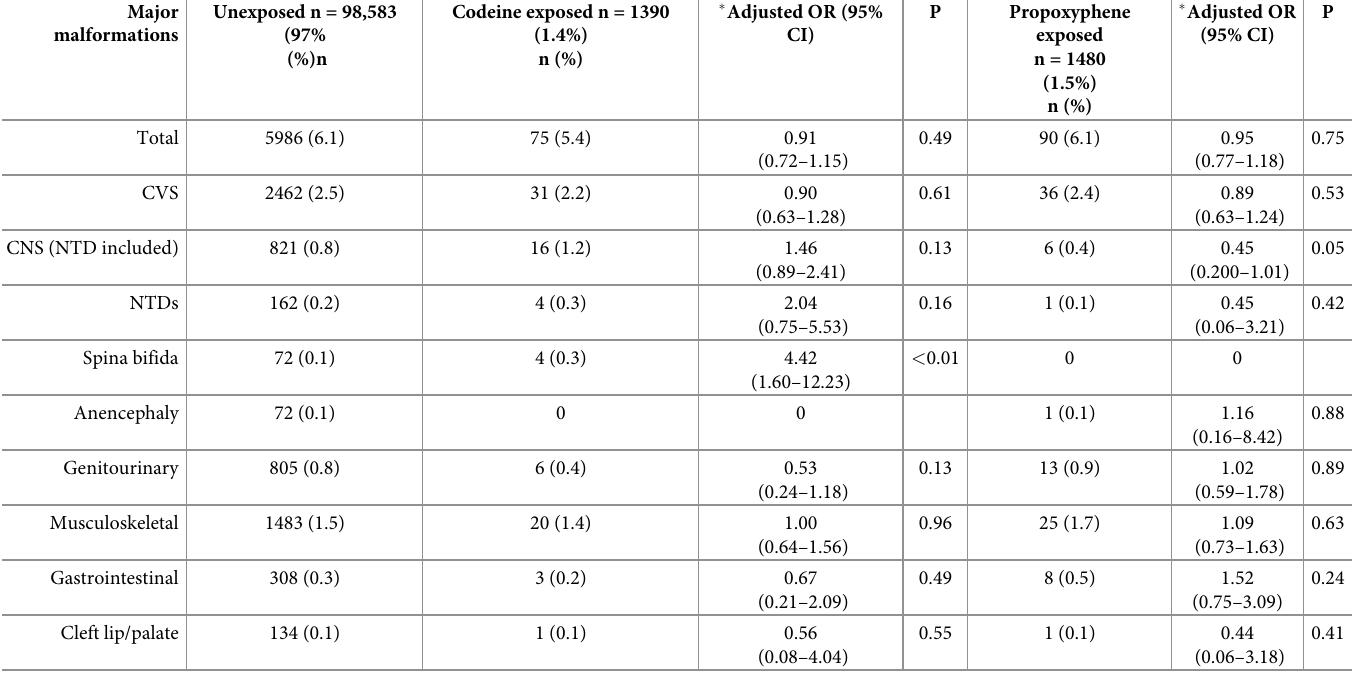
Table 3. Odds ratios for congenital malformations after intrauterine exposure to codeine or propoxyphene during the first trimester of pregnancy compared to unexposed. Major